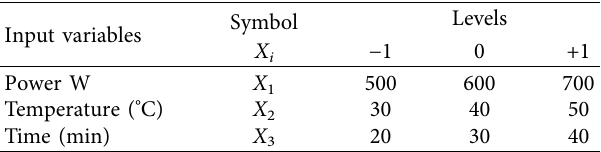
Table 1: Independent factors and its range set in experiment